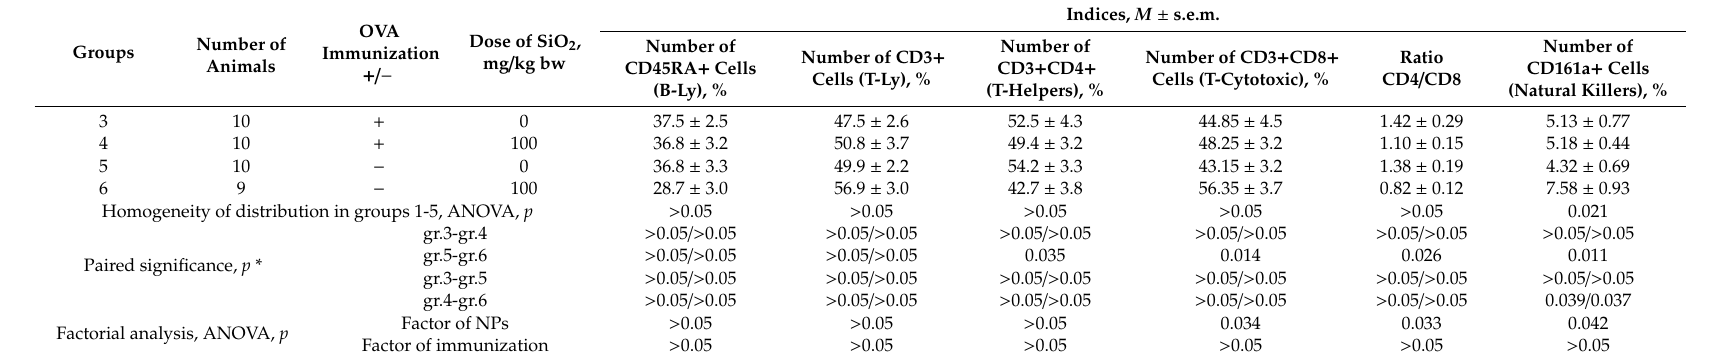
Table 5. Cellular immunity indices in rat groups 3–6 on the 29th day of the